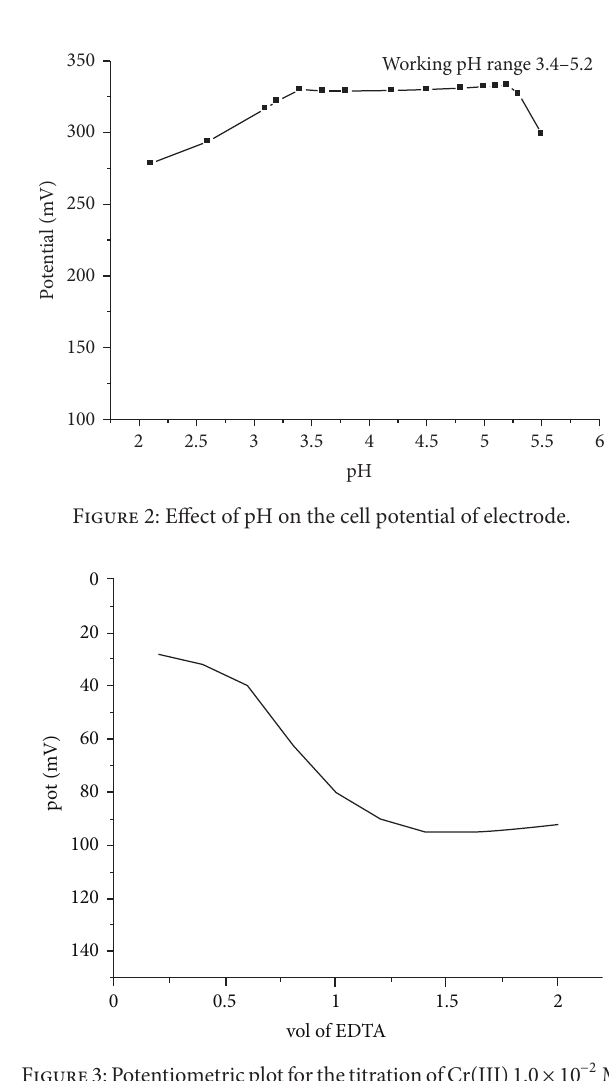
T1:Potentiometricselectivitycoefficientvalues(K pot